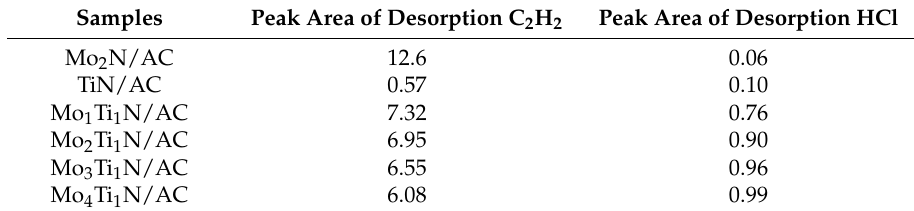
Table 2. Calculation of peak area of different catalysts’ desorption reactant.